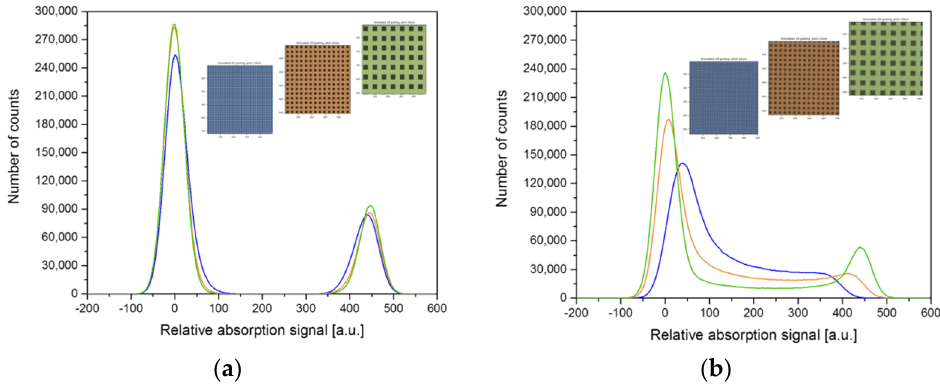
Figure 7. Simulated gratings intensity distribution histograms with added detector noise and cropped simulated data arrays with dimensions corresponding to the periods of 50 μ m (green), 25 μ m (orange), and 10 μ m (blue): ( a ) ideal data arrays; and ( b ) tilted at − 0.6° and blurred data arrays. The simulation represents the influence of generalized pattern defects and was used to decouple them from the impact of local imperfections.